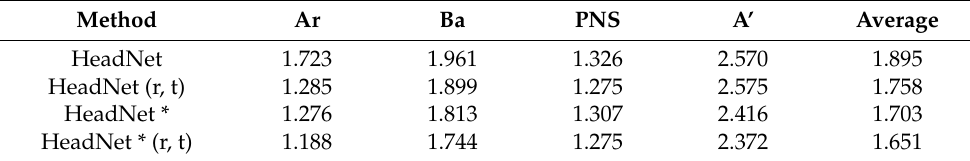
Table 3. Absolute localization error (pixel) over keypoints between different models in the test dataset.